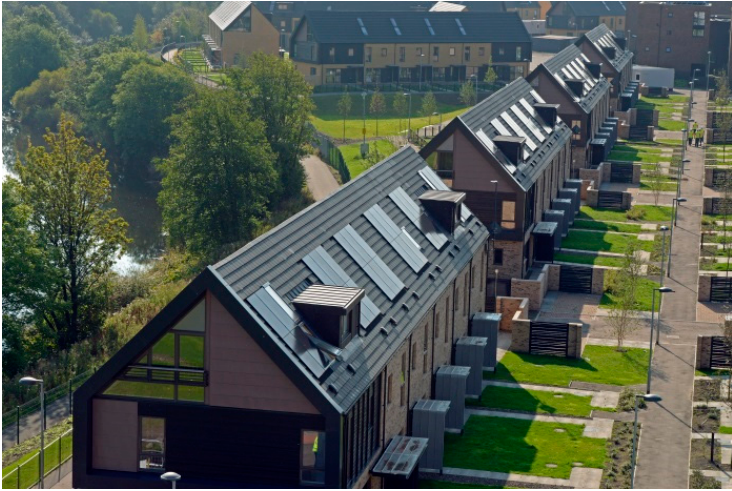
Figure 1. Commonwealth Games Athlete’s Village in Glasgow (Scotland), by Solar Trade Association (CC BY ‐ SA 2.0).